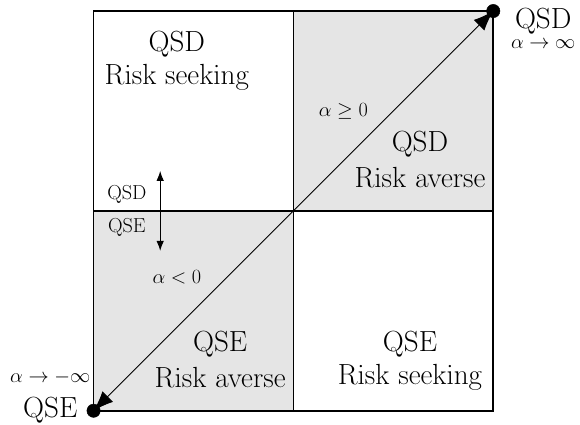
FIG. 3. Possible scenarios for quantum state discrimination and quantum state exclusion games being played by gamblers with different risk tendencies: risk averse, risk seeking, or risk neutral, with the risk being parametrized as R (α) = 1 /α . Result 1 establishes that Arimoto’s mutual information quantifies the shaded region for α ∈ R , meaning that it characterizes risk- averse gamblers playing either QSD ( α ≥ 0) and QSE games ( α < 0). The left-bottom corner (α → −∞ ) and the top-right corner (α → ∞ ) represent a risk-neutral gambler R = 0 playing either standard exclusion or discrimination games, respectively. This means that standard QSD games can be understood as a risk-neutral gambler playing QSD games with risk. Similarly, standard QSE games can be understood as a risk-neutral gam- bler playing QSE games with risk. The middle point at α → 0 represents the transition between a maximally risk-averse gam- bler playing QSD games and a maximally risk-averse gambler playing QSE